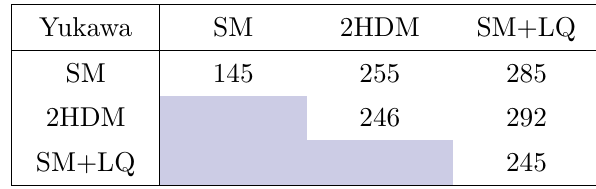
Table 2 . The number of independent constraints on the Yukawa coefficients from combining any two of the models, with the diagonal being the constraints from the individual models.